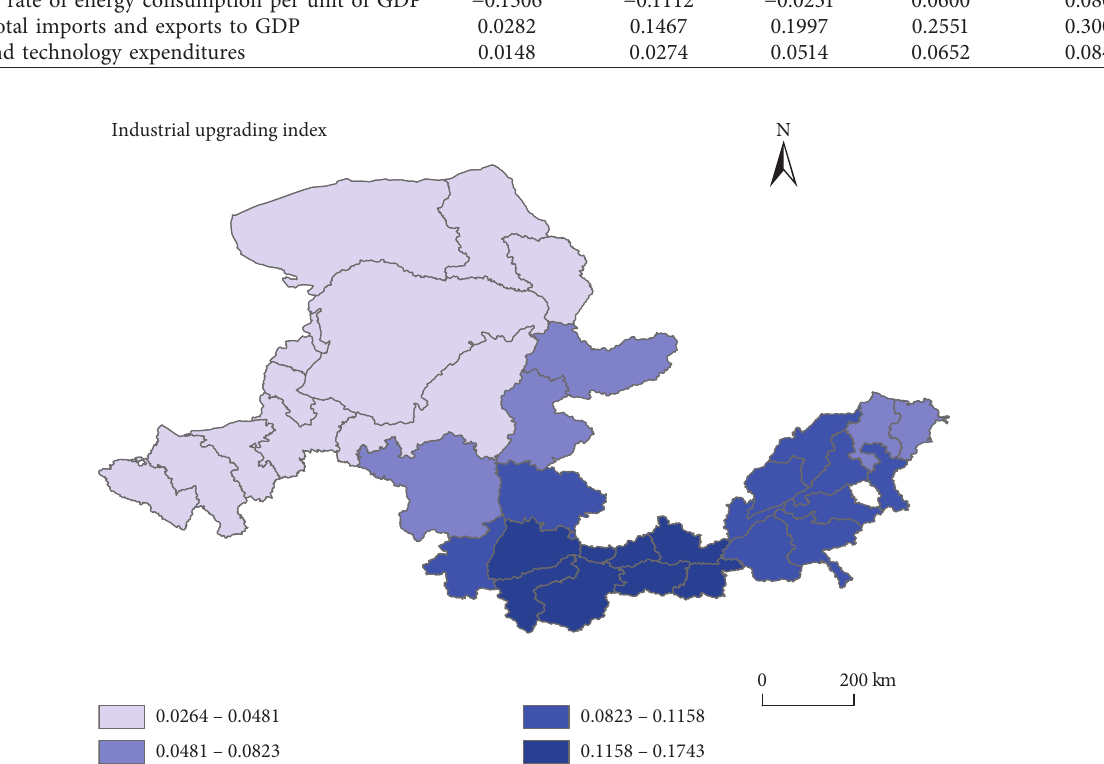
Figure 4: Spatial distribution of regression coefficient of the industrial upgrading index on IGD.